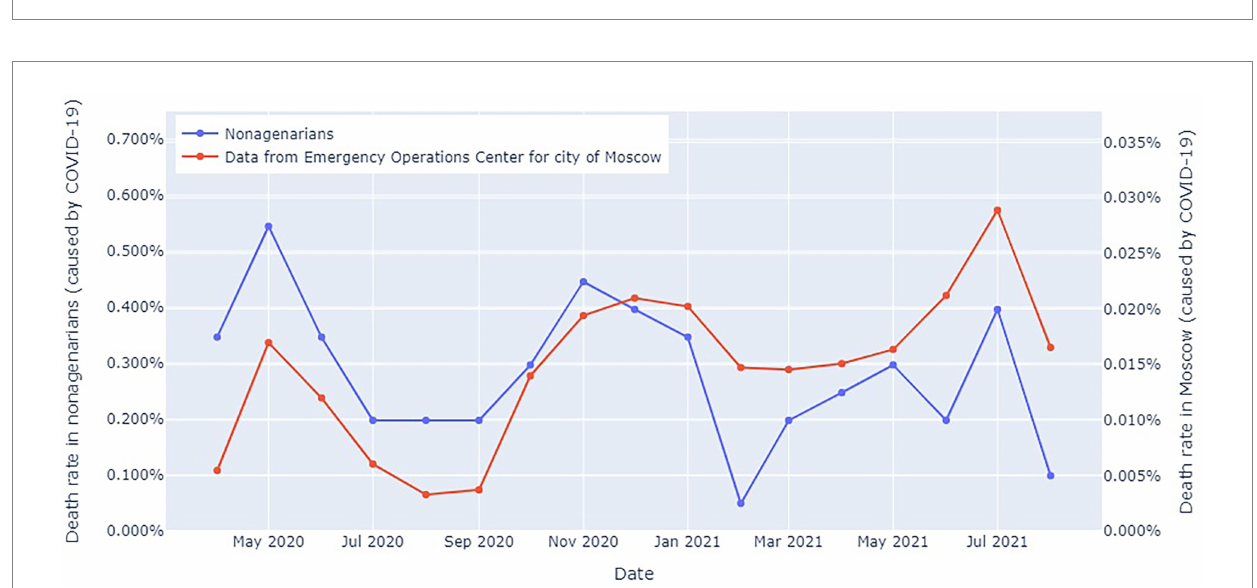
FIGURE 4 COVID-19-related mortality dynamics in the entire Moscow population and in the study participants from Moscow from April 2020 to October 2021. The blue line: officially reported COVID-19-related mortality in Moscow (17); the red line: COVID-19-related mortality in the long-living